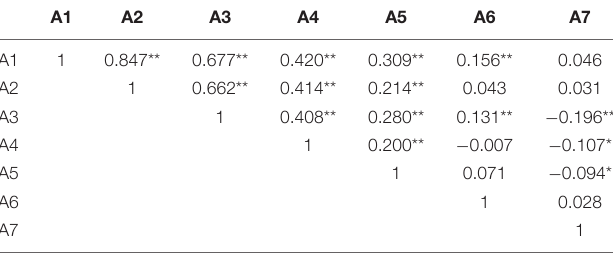
TABLE 8 | Pearson correlations among translation competence